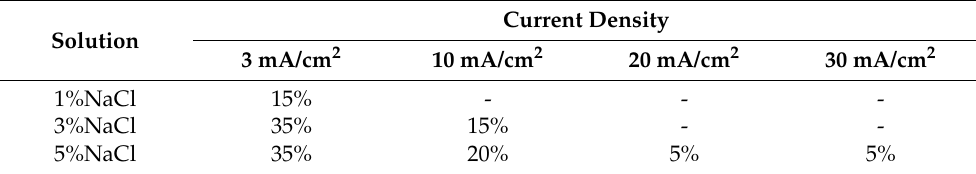
Table 3. Corrosion degree of steel bars at two-stage transition of corrosion efficiency in NaCl solution.